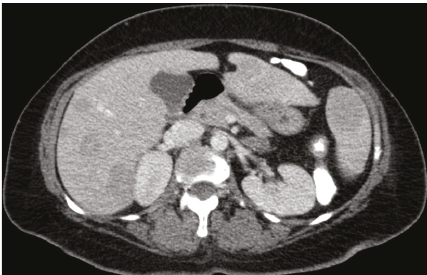
Figure 2: CT of the abdomen showing numerous low attenuation lesions in the liver and spleen suspicious for metastatic disease along with soft tissue nodules in the anterior abdominal wall and numerous lytic lesions in the axial skeleton.